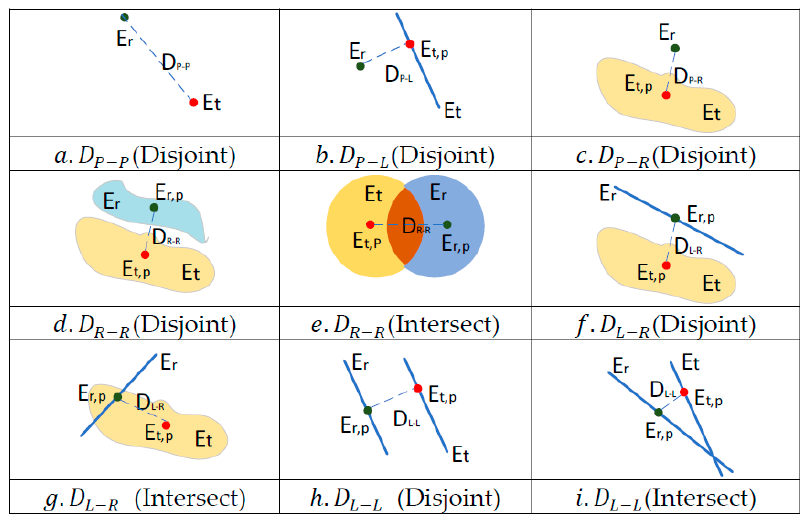
Figure 4. Visual space distance model.